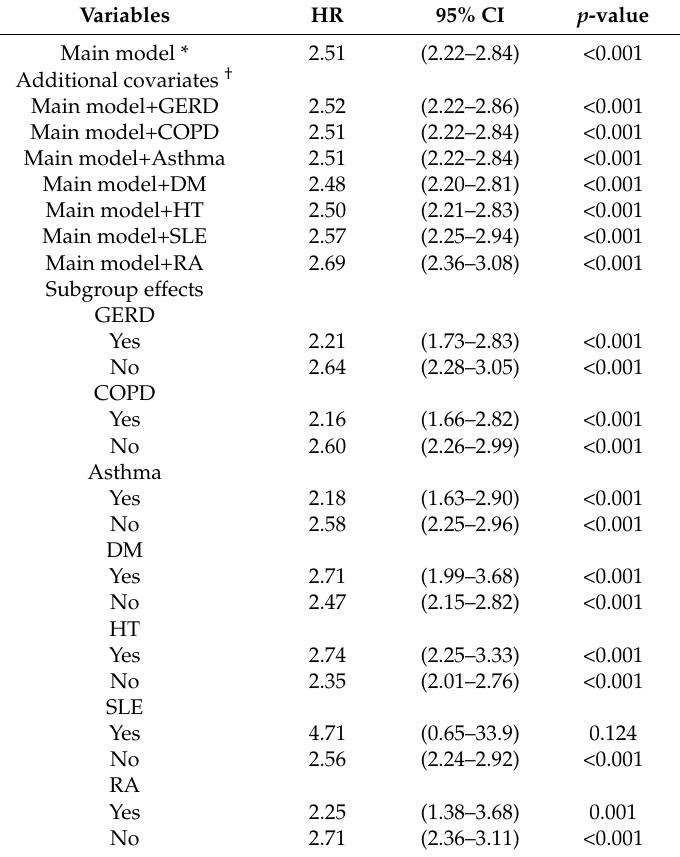
Table 3. Analysis of Medical and Surgical Therapies for CRS in SS and Non-SS.